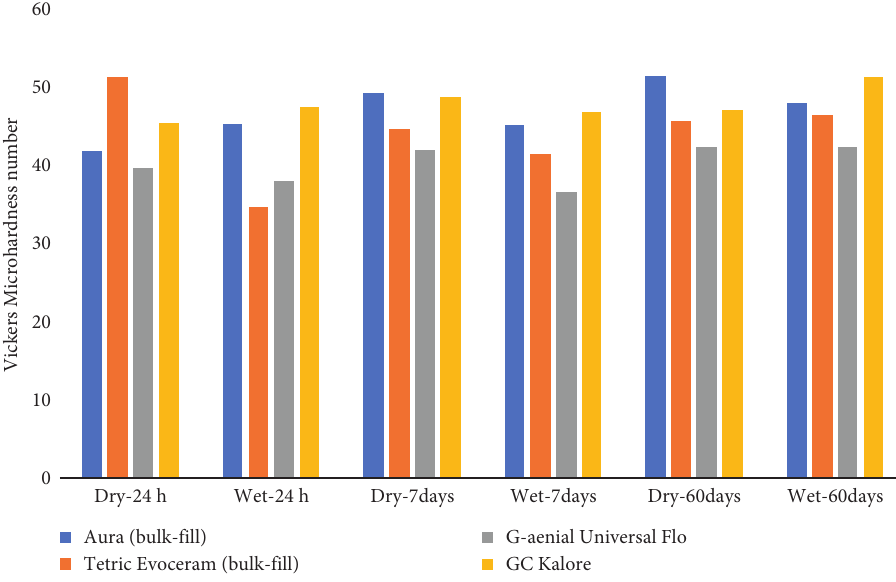
Figure 1: Mean values for fracture toughness of all materials. Table 3: Comparison of mean ± SD values of Vickers microhardness between all materials after wet or dry storage, analysed by independent t